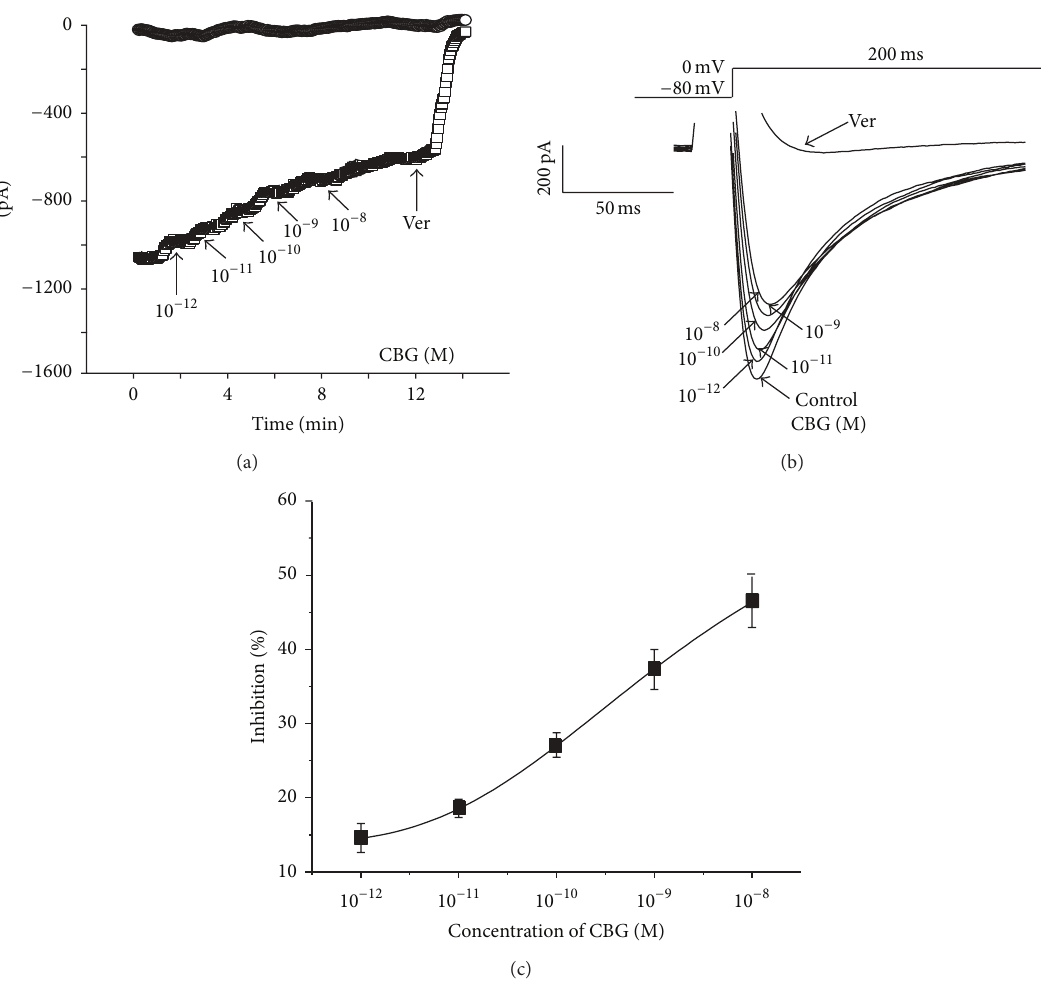
. (a) Time course of 𝐼 recorded under control conditions, during exposure to 10 −12 , 10 −11 , Ca-L Ca-L evoked in the absence and presence of CBG derivatives. (c) Dose-response Ca-L . Data are presented as means ± S.E.M. ( 𝑛 = 5 –7 Ca-L